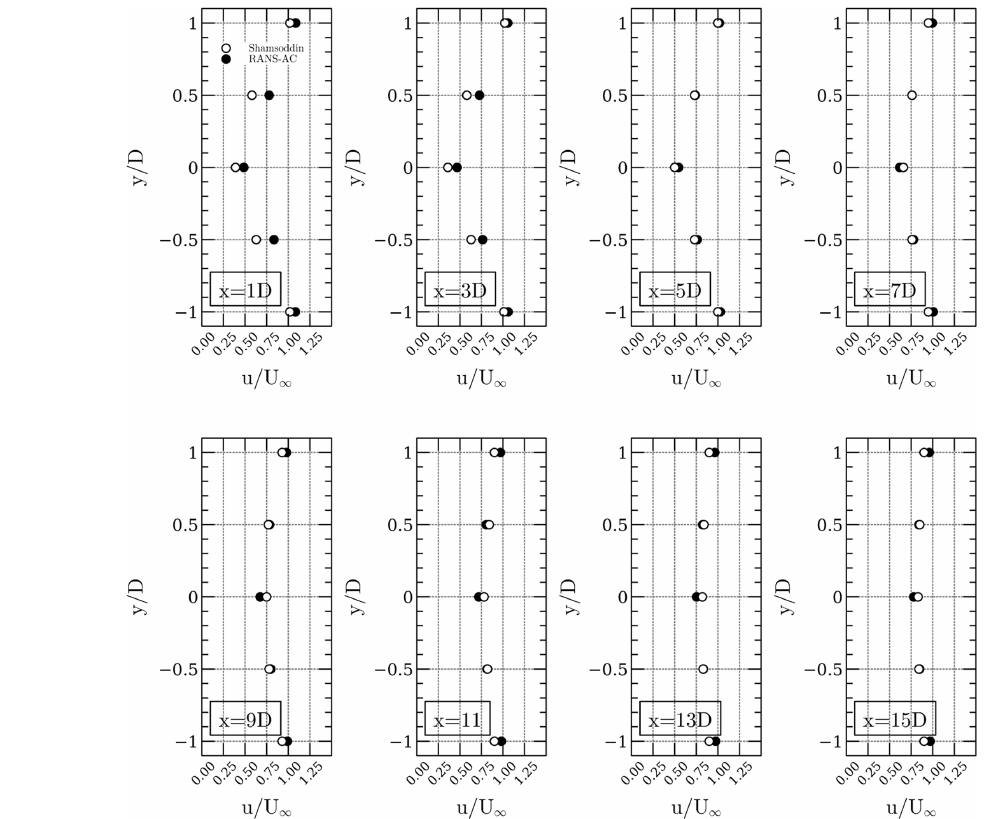
Figure 15. Comparison of the LES wake at different downwind distances with the current RANS-AC results.